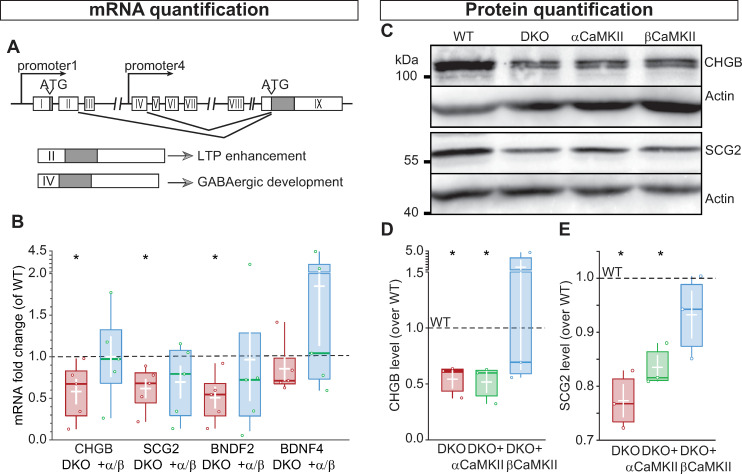
CaMKII regulates neuropeptide expression.(A) Representation of BDNF genomic locus, exons are shown as white boxes, the gray box represents the conserved exon shared between the different transcripts. (B) Quantification of mRNA fold change, expressed as ΔCt values normalized to WT, showing the reduction of mRNA levels for CHGB, SCG2, and BDNF transcript 2 in DKO neurons compared with DKO neurons rescued with α and βCaMKII. BDNF transcript 4 is not affected by the lack of CaMKII. (C) Western blot showing the DCV cargo proteins CHGB (top) and SCG2 (bottom) in WT, DKO, and DKO-expressing αCaMKII or βCaMKII neurons. Actin was used as loading control. (D) Quantification of CHGB levels normalized to WT. (E) Quantification of SCG2 levels normalized to WT. Boxplots with 95% CI whiskers, white cross shows mean ± SEM, and central bar is the median. Columns and dots represent individual litters and neurons, respectively. The presented data can be found in S1 Data; original Western blot can be found in S1 Raw images. ATG, transcription starting codon; BDNF, brain-derived neurotrophic factor; CaMKII, Ca2+/calmodulin-dependent kinase II; CHGB, chromogranin B; CI, confidence interval; DCV, dense-core vesicle; DKO, double-knockout; LTP, long-term potentiation; SCG2, secretogranin2; WT, wild type.